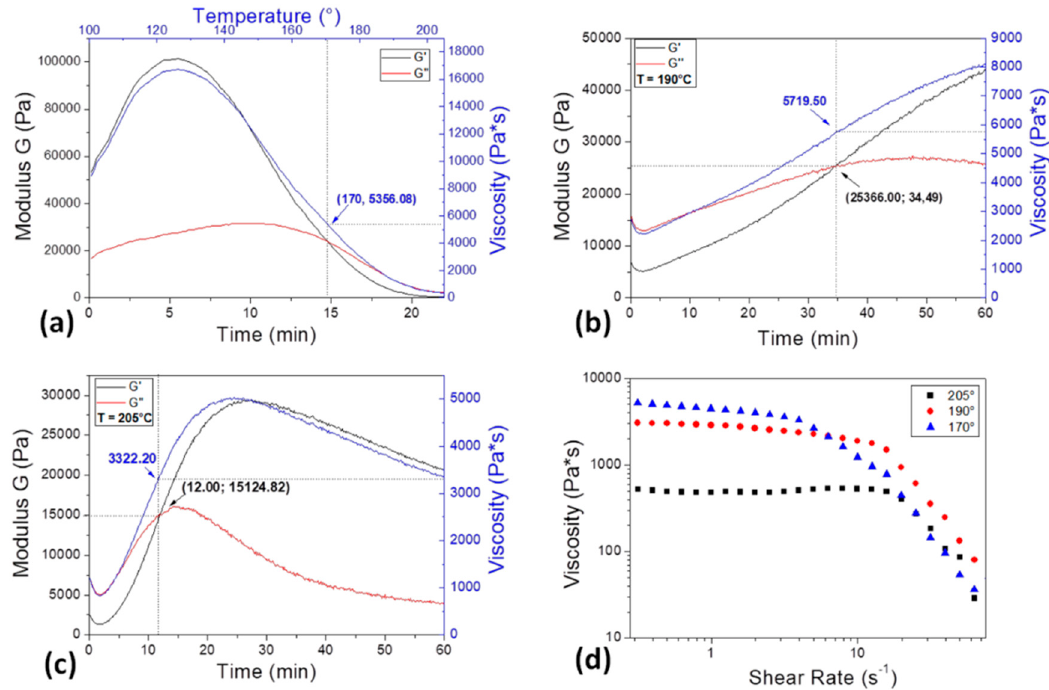
Figure 2. Rheological analysis on PDMS pellets: ( a ) dynamic rheological ramp test; ( b ) isothermal characterization at 190 °C and ( c ) at 205 °C; ( d ) viscosity vs. shear rate at different temperatures of interest.